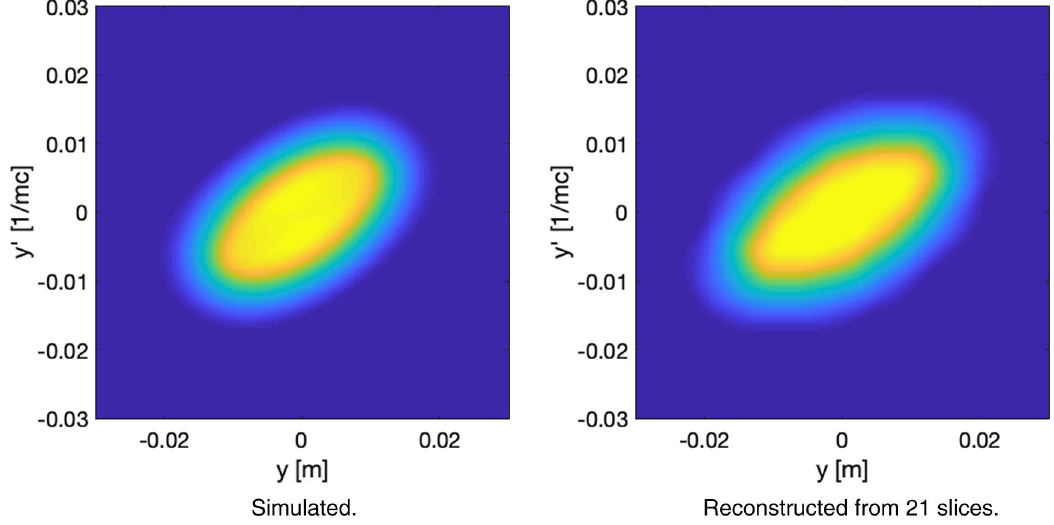
FIG. 9. Vertical effective phase space, (left) simulated, (right) reconstructed.